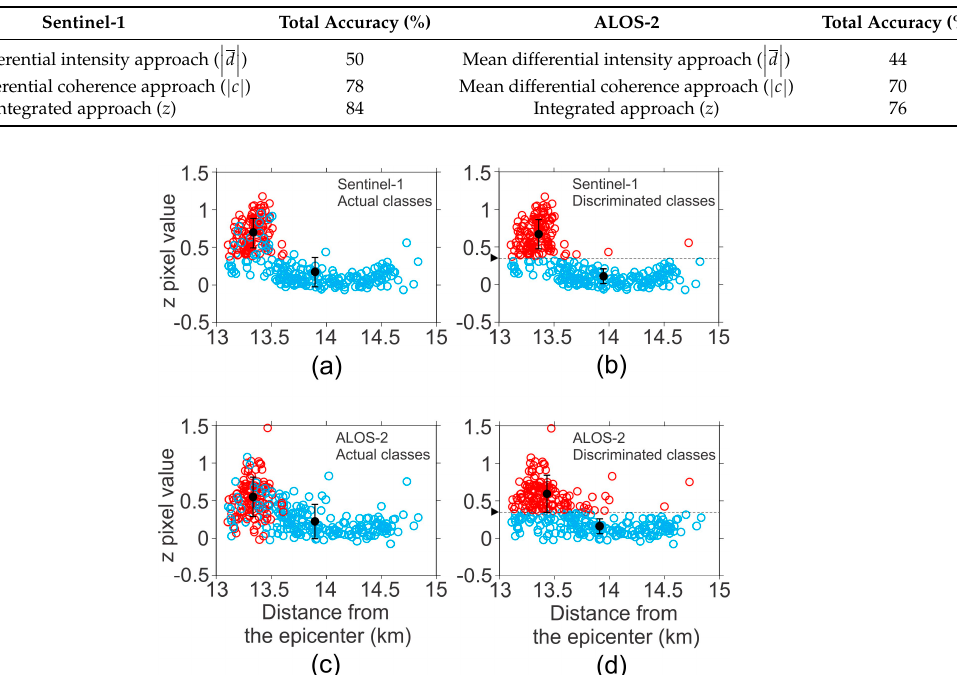
Table 4. Results of the accuracy assessment of different approaches.